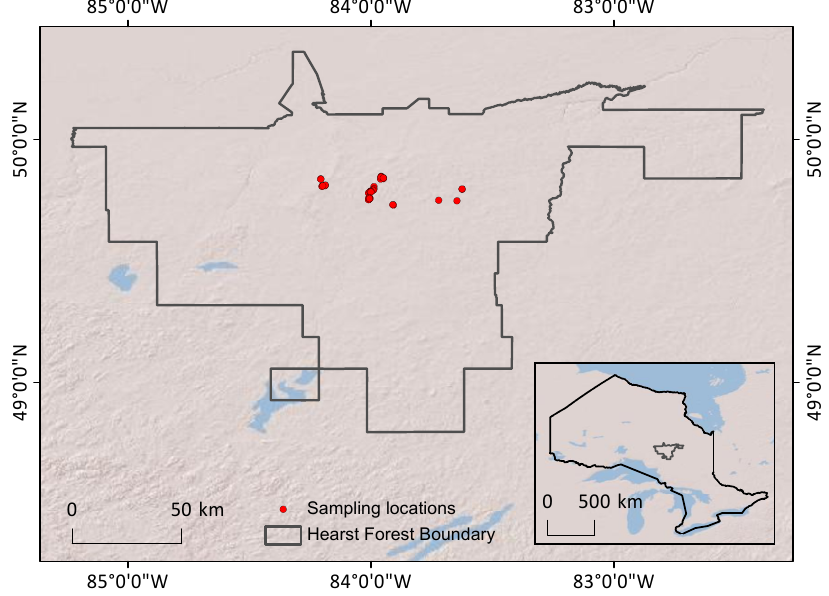
Figure 2. Map of sampling locations within Hearst Forest and of Hearst Forest‘s location within Ontario